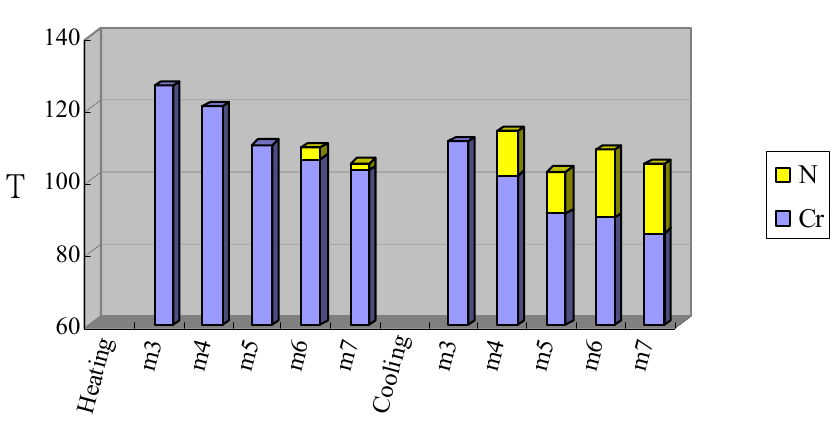
Figure 5. Plot of transition temperatures of heating and cooling cycle for compounds of 2-(4'-alkoxyphenyl)-6-methylquinoline ( m O-PQMe, m =